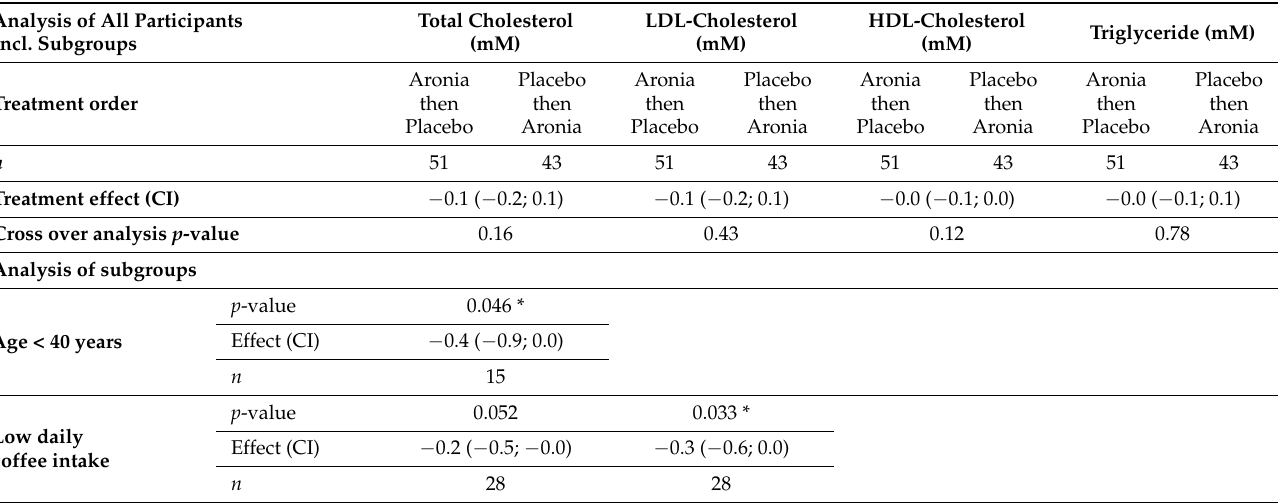
Table 3. Effects of 90 days Aronia spp. administration on TC, LDL-C, HDL-C, and TG. CI = Confi- dence